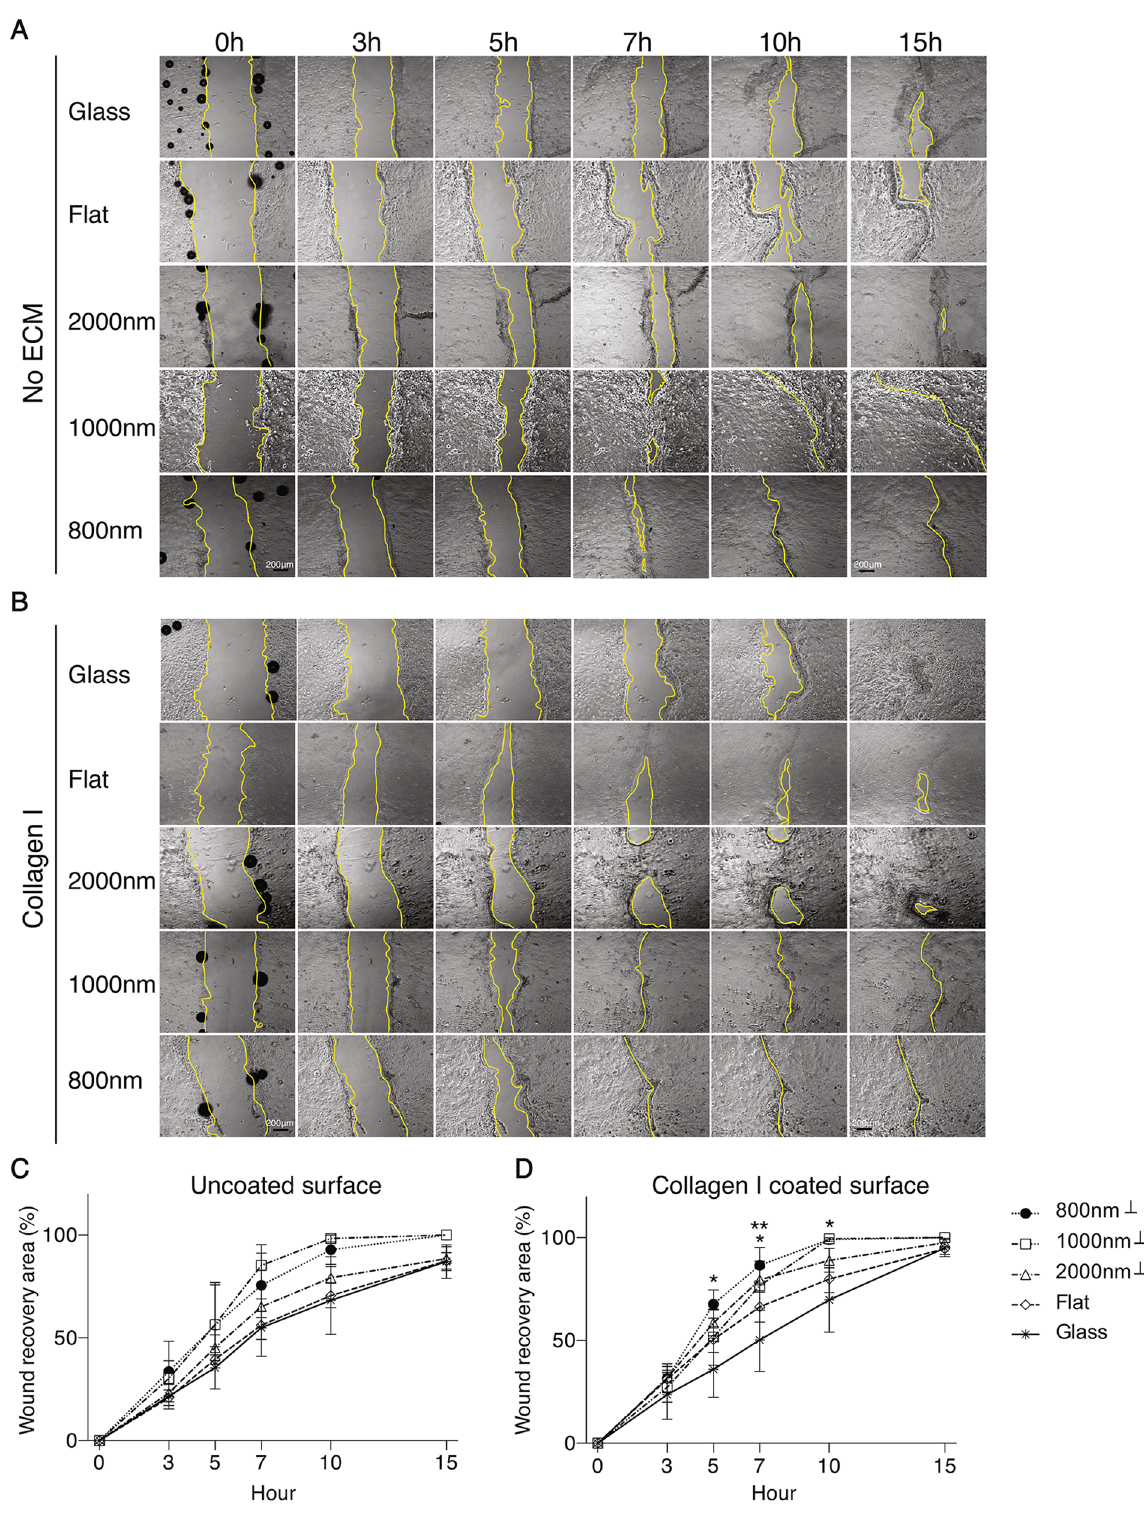
Figure 5. Nanotopographies and collagen I coating promoted in vitro wound healing of RCEC. Scratch assays were performed on confluent monolayer of cells grown on uncoated or collagen I coated glass, flat, 2000 nm, 1000 nm and 800 nm patterned silk films. Time-lapse images recorded every 20 min for 15 h were analyzed and the yellow lines delineated the wound edge of the scratched monolayer. Representative images of cells grown on uncoated ( A ) or collagen I coated ( B ) surfaces. Quantification of wound healing rate on uncoated surfaces shows that faster wound recovery occurred on the 1000 and 800 nm topography ( C ) and increased on the collagen I coated surfaces ( D ) (* indicates p < 0.05 when compared glass to 800 nm topography at 5-h time point; when compared glass to 2000 nm topography at 7-h time point; when compared glass to 800 nm topography at 10-h time point. ** indicates p < 0.005 when compared glass to 800 nm topography at 7-h tine point. Symbol on legends, ⊥ , indicates the scratch was perpendicular to the parallel lines. Values are means ±